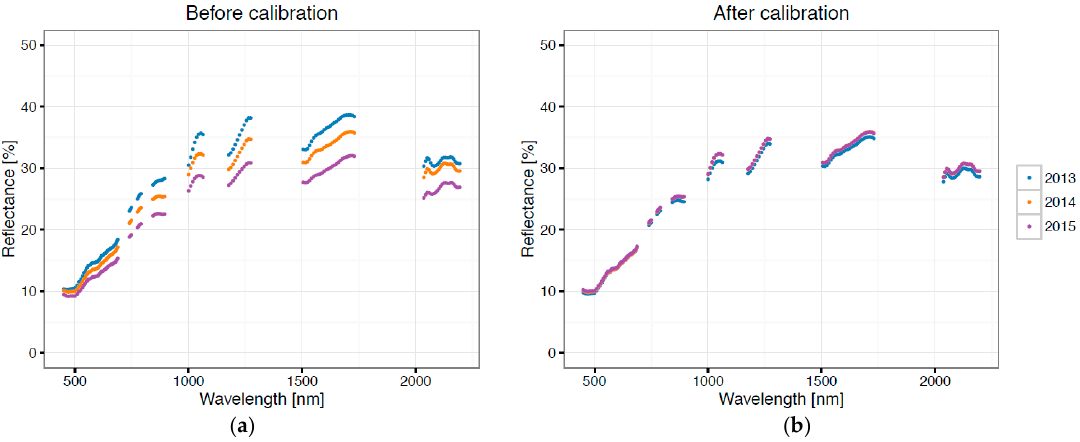
Figure 4. Mean reflectance values for all three years (2013, 2014, and 2015): before ( a ); and after ( b ) calibration.